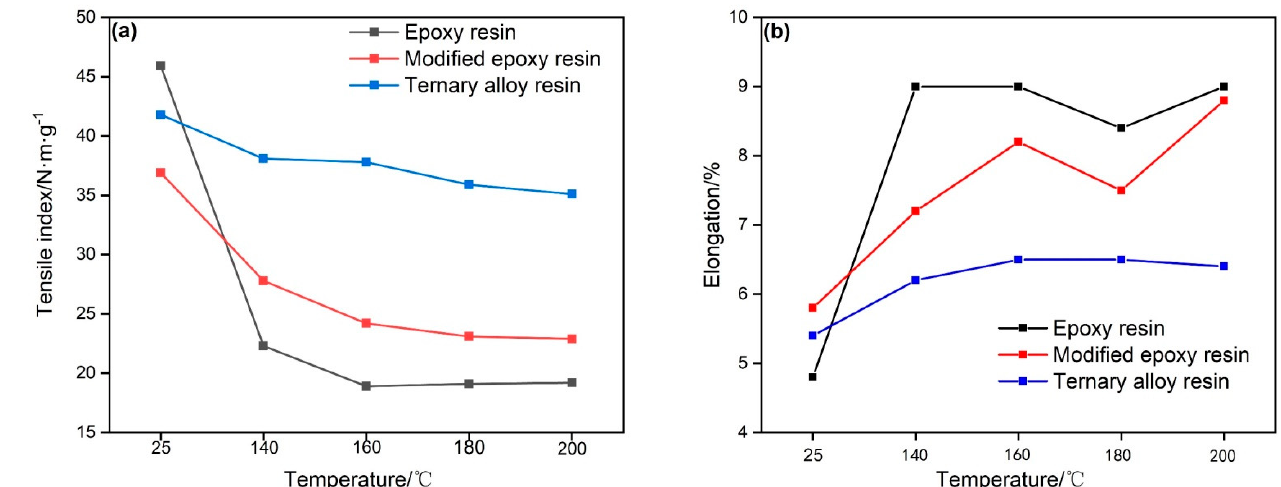
Figure 4. Performance comparison of different resin-impregnated paper-based composites: ( a ) Tensile strength, ( b ) Elongation.